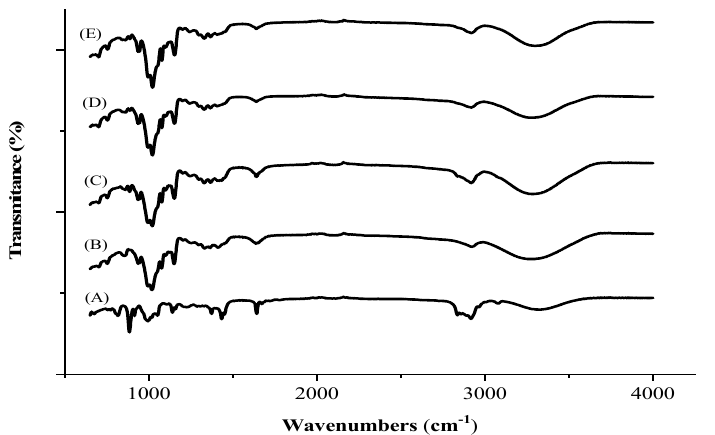
Figure 2. Fourier transform spectrophotometry ( A ) Perillyl alcohol, ( B ) β -cyclodextrin, ( C ) Co- evaporation, ( D ) Malaxation and ( E ) Physical mixture.